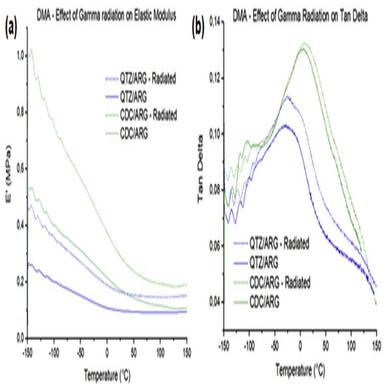
Storage Modulus (left) and Tan delta curves (right) measured by DMA in compression mode, before and after gamma radiation exposure.